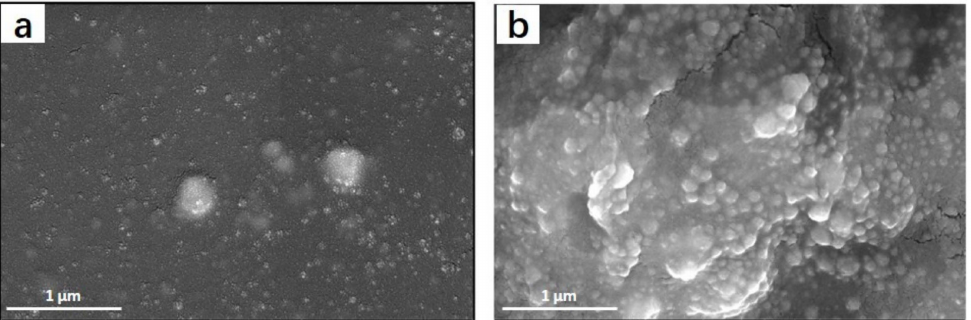
Figure 11. SEM images of Mod-Ch-Ag NPs ( a ) before and ( b ) after addition of Hg 2+ ions [110]. Copyright Elsevier,